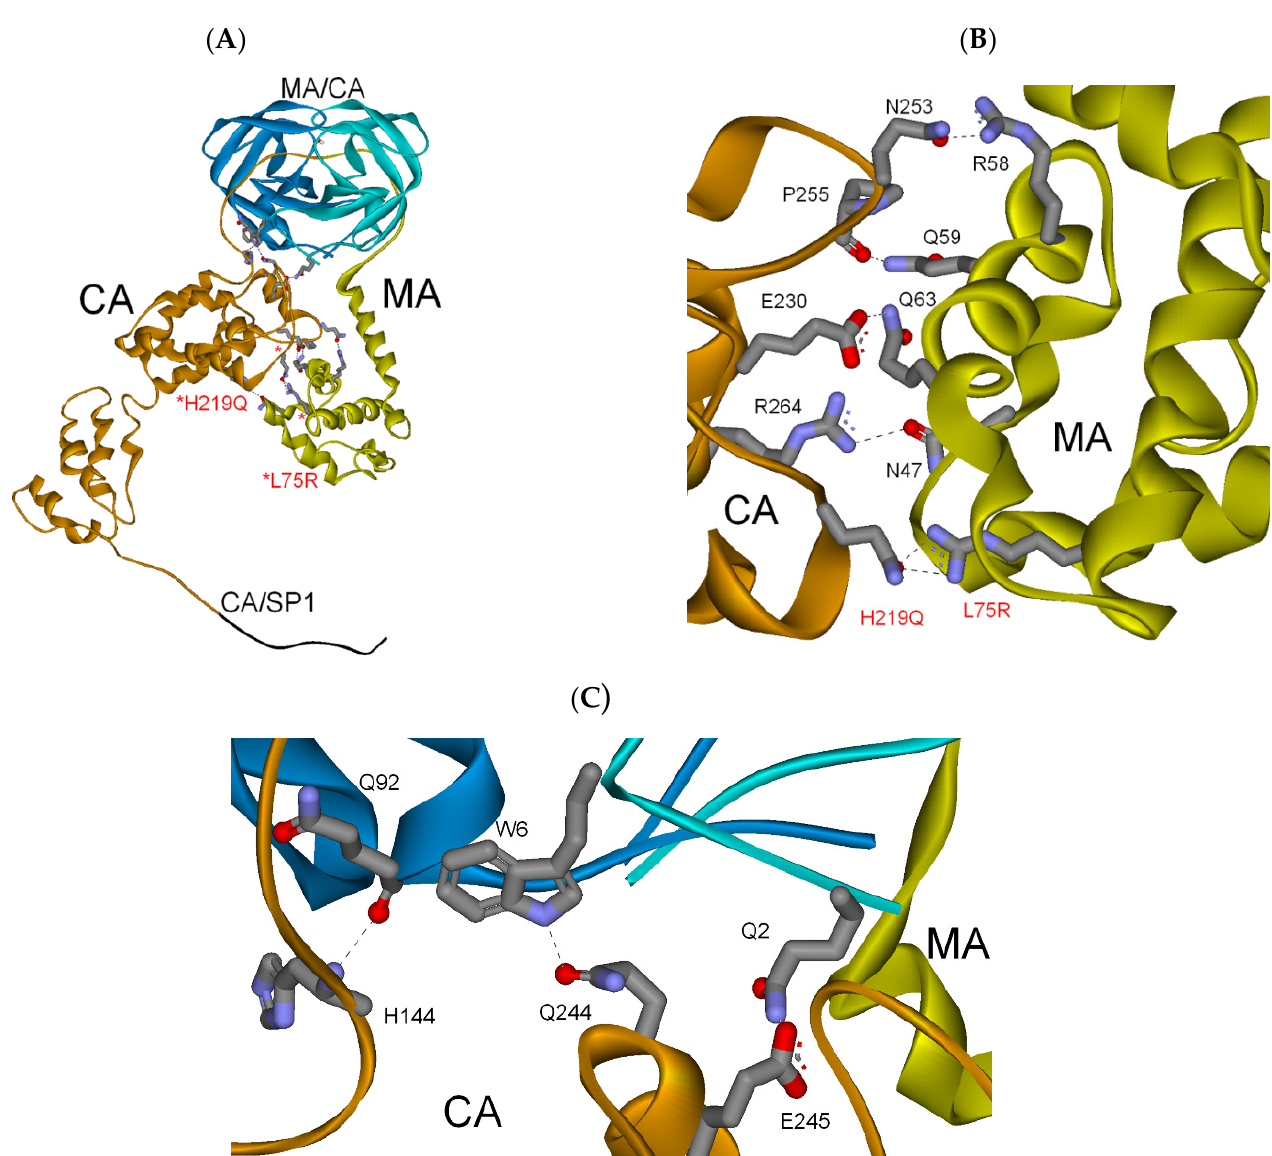
Figure 6. ( A ) HIV-1 PR (front view) bound to MA/CA cleavage site in MA-CA-SP1 polyprotein with Gag non-cleavage site PI resistance double mutation L75R/H219Q (red labels) which coordinated a substrate-clamp between MA and CA subdomains. PR backbone ribbon A-subunit teal, B-subunit blue), MA-CA-SP1 backbone ribbon (MA yellow, CA bronze, SP1 black), substrate-clamp residues shown (carbon grey, oxygen red, nitrogen blue). ( B ) Close-up of ( A ), H-bond interactions between MA and CA subdomain residues coordinated by Gag non-cleavage site PI resistance double mutation L75R/H219Q (bottom, red labels), native CA residues (left side) R264, E230, P255, N253, and native MA residues (right side) N47, Q63, Q59, and R58. ( C ) Close-up of ( A ), H-bond interactions between native CA subdomain residues and native PR residues coordinated by the Gag non-cleavage site PI resistant double L75R/H219Q mutation. Native CA residues (lower) H144, Q244, and E245 and PR A-subunit residues (upper right) Q2 and W6, and PR B-subunit residue (upper left) Q92; H-bonds shown as dashed black lines. See Results and Discussion Section 3.2.3 for detailed description of the substrate-clamp H-bond network.